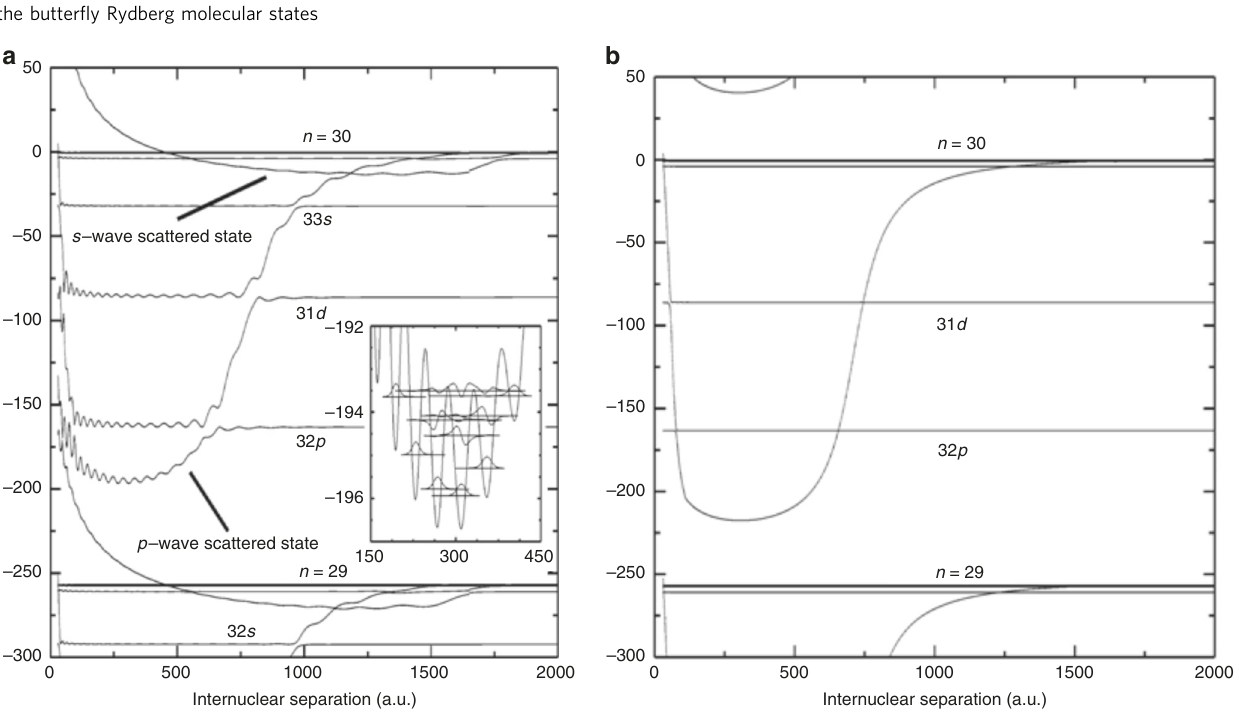
Fig. 1, are formed by pairing Rydberg atoms with attractive long- range and repulsive shorter range interactions such that potential wells can form. Due to the large polarizability of Rydberg atoms and high density of states, the bond lengths can be larger than